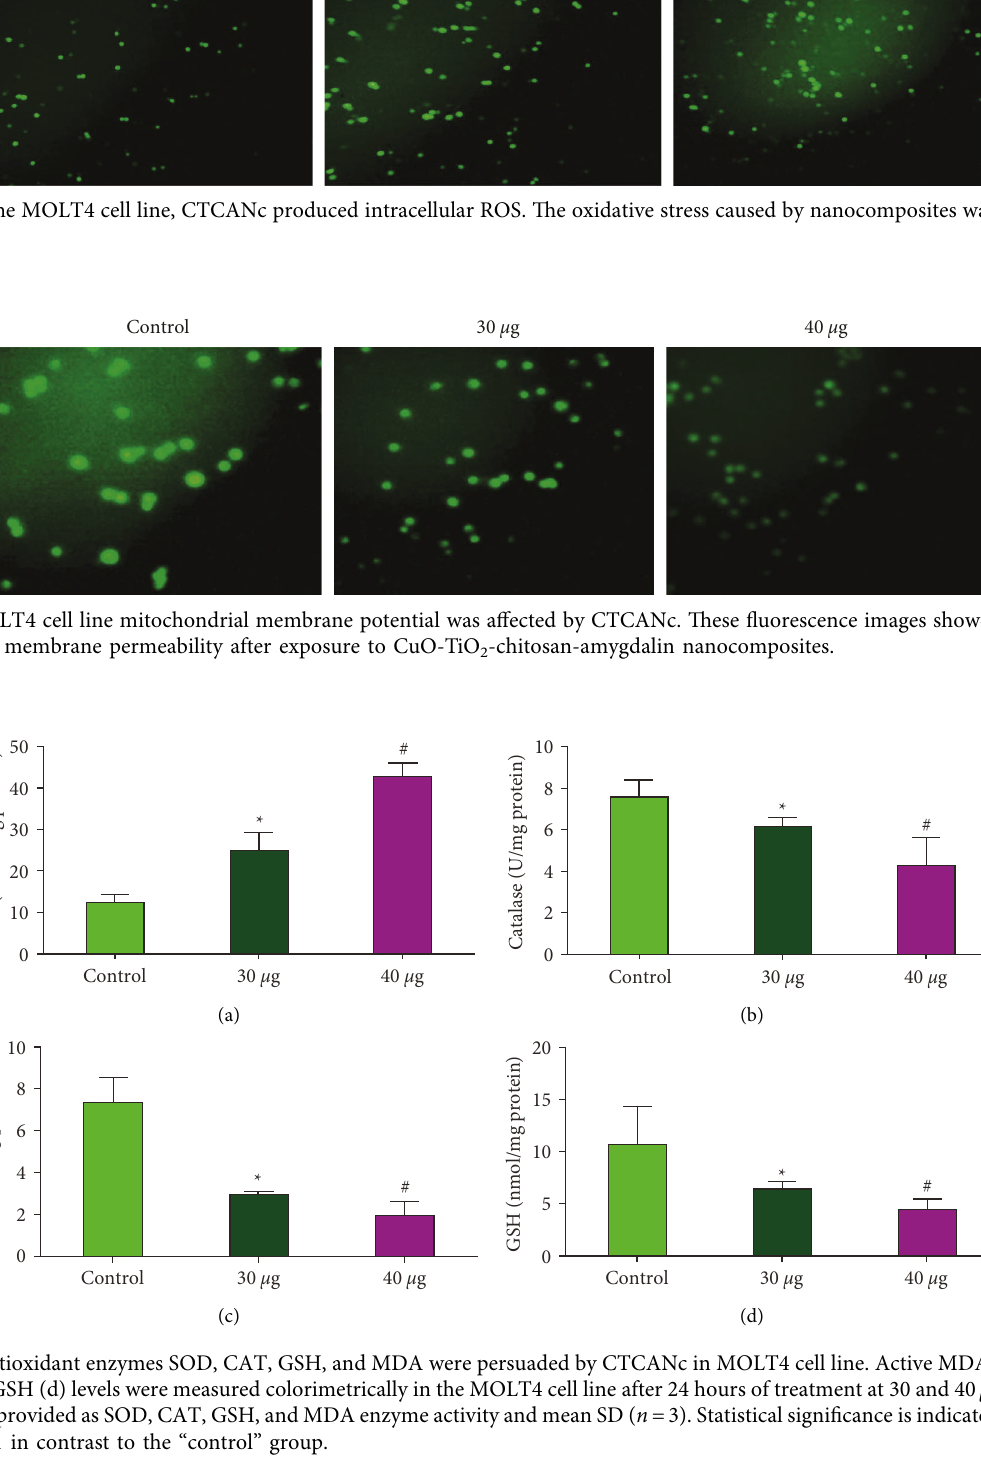
Figure 10: Antioxidant enzymes SOD, CAT, GSH, and MDA were persuaded by CTCANc in MOLT4 cell line. Active MDA (a), CAT (b), SOD (c), and GSH (d) levels were measured colorimetrically in the MOLT4 cell line after 24 hours of treatment at 30 and 40 μ g/ml dosages. The data were provided as SOD, CAT, GSH, and MDA enzyme activity and mean SD ( n � 3). Statistical significance is indicated by ∗ p < 0 . 05 and # p < 0 . 001 in contrast to the “control”